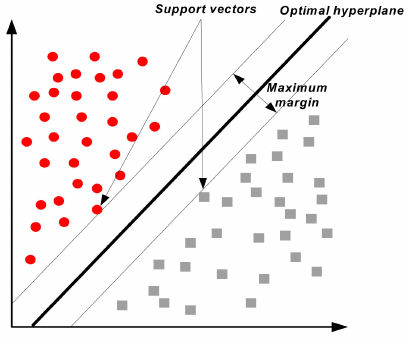
Figure 9. Conceptual diagram of the support vector machine